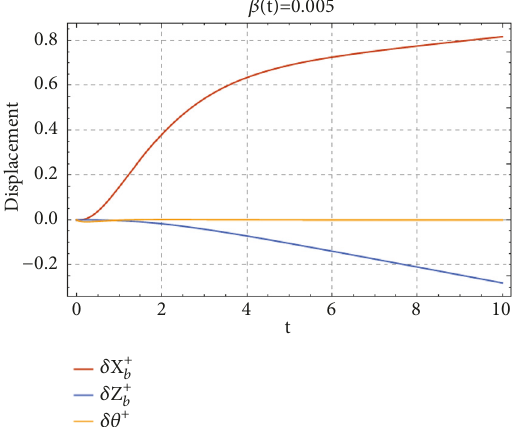
Figure 6: Displacementof an FMAVwith its tail controlled by astep